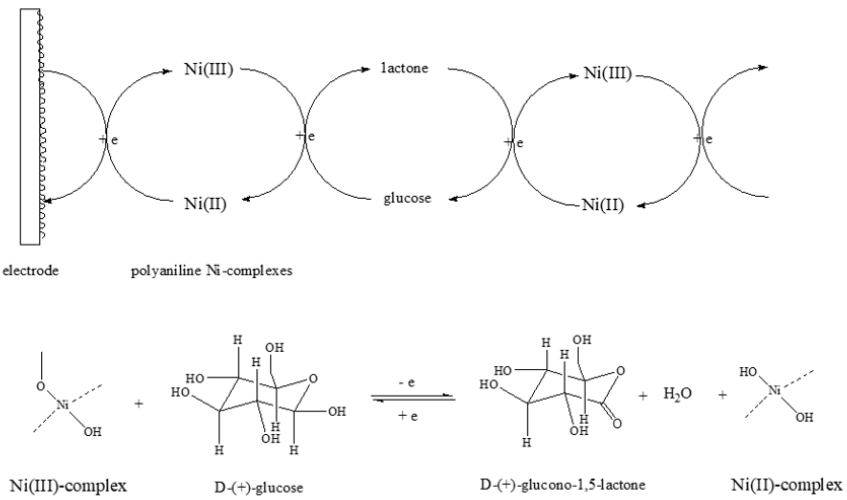
Figure 10. Catalytic redox mechanism of glucose on polyaniline Ni-complex electrode prepared by plasma process for detection of phosphate.